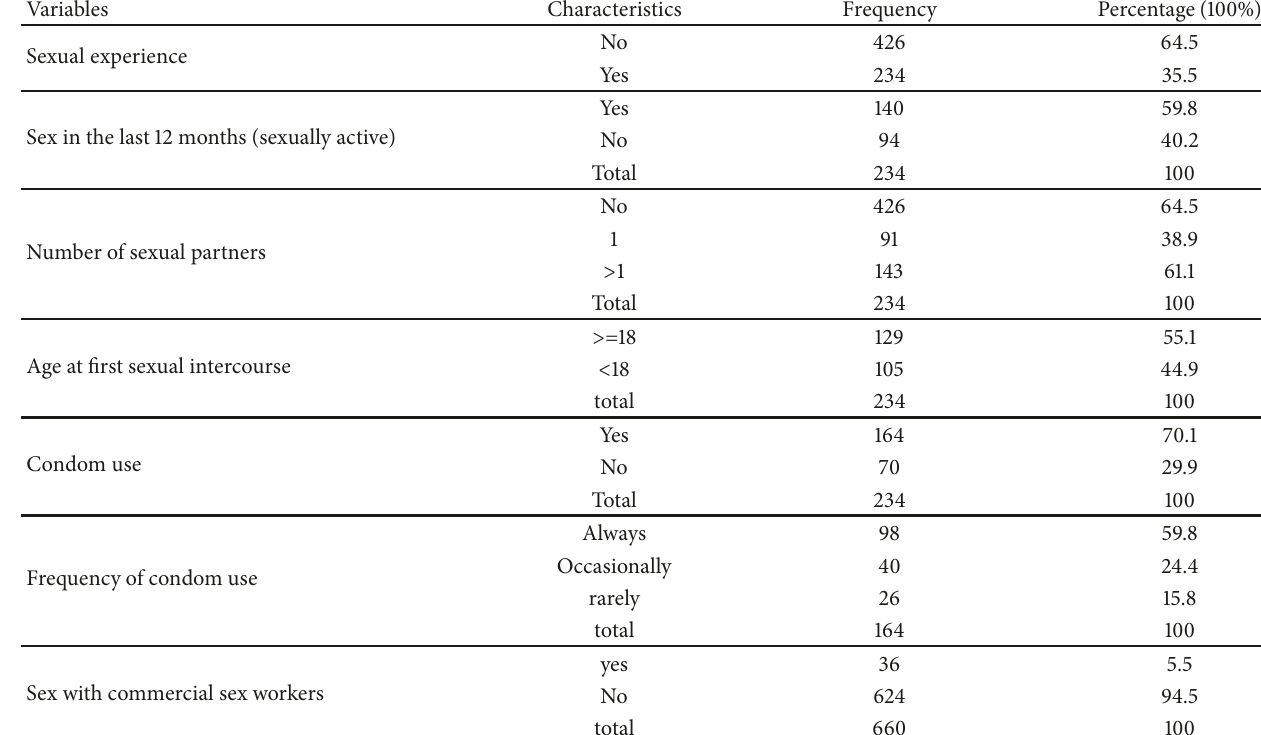
Table 3: Participant’s sexual practices and risky sexual behavior of Jimma University students, April,